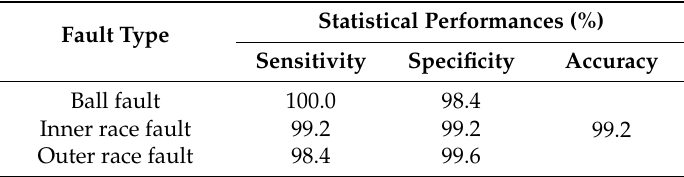
Table 3. Statistical performances, segments of the design set.